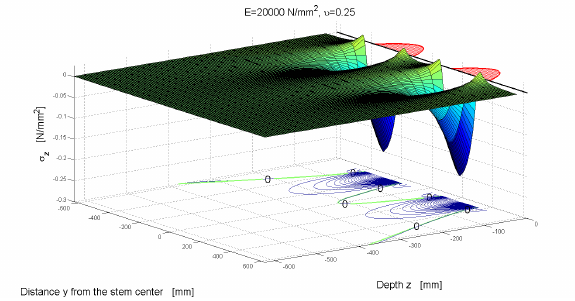
Figure 38: Paraboloid load distribution over the two elliptical tire- ground contact areas (the A-A vertical section is taken along the cross-section of the twin wheel).